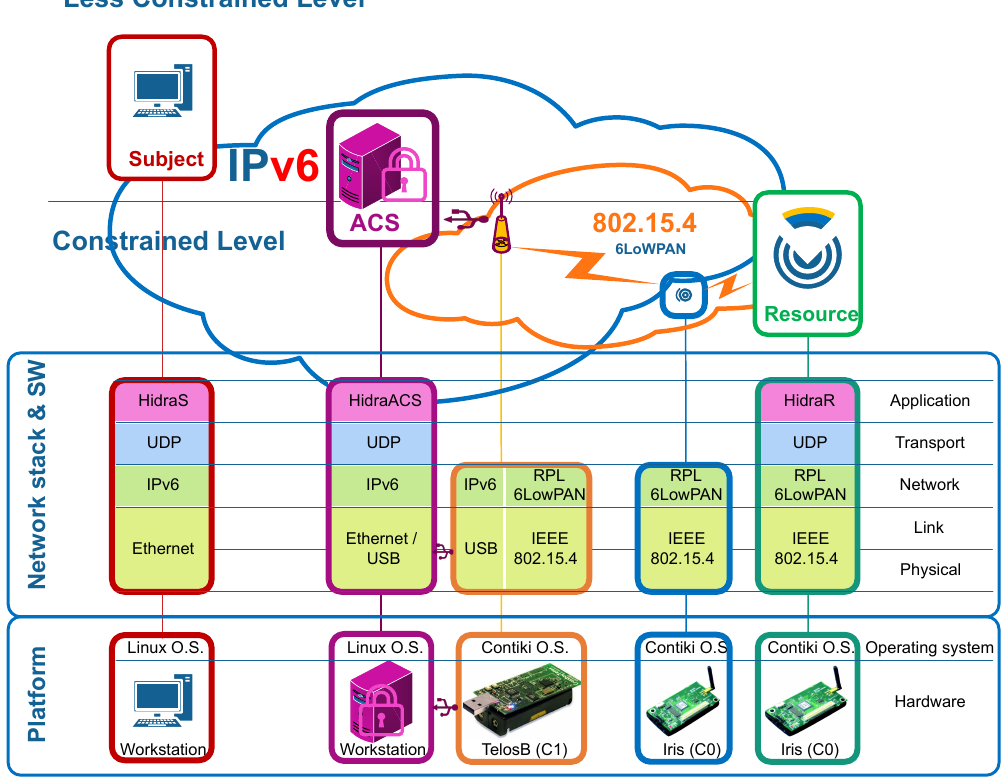
Figure 5. Performance evaluation scenario. Hidra protocol implementation conveying the hardware, operating system, network stack and Hidra software